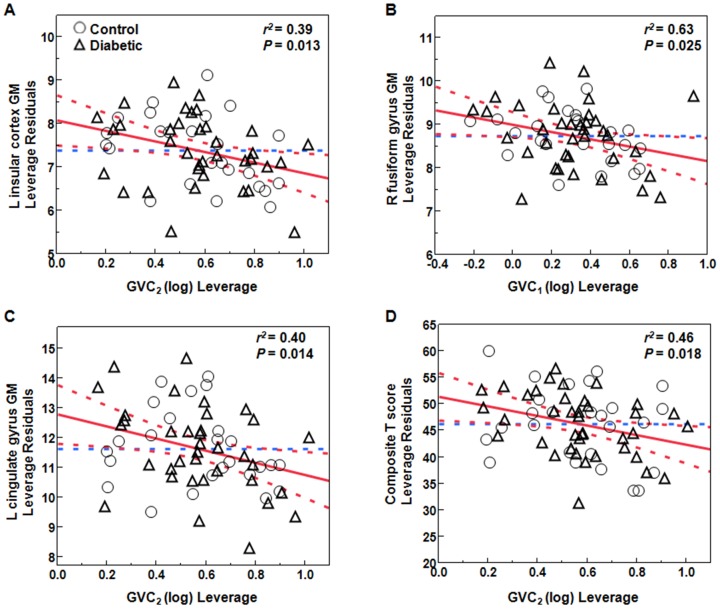
Examples of least squares models indicating negative relationships between Multi-Scale GV and regional GM volumes as well as cognitive performance.(A) relationship between GVC2 and GM volume in the left insular cortex; (B) relationship between GVC1 and GM volume in the right fusiform gyrus; (C) relationship between GVC2 and GM volume in the left cingulate gyrus; (D) relationship between GVC2 and overall cognitive performance (composite T score) (diabetics: triangles; controls: circles). We presented r2 for the entire model adjusted for age and sex and group, and P values for the specific effect of Multi-scale GV.